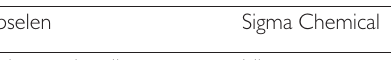
Figure 1. Schematic representation of the properties of ebselen